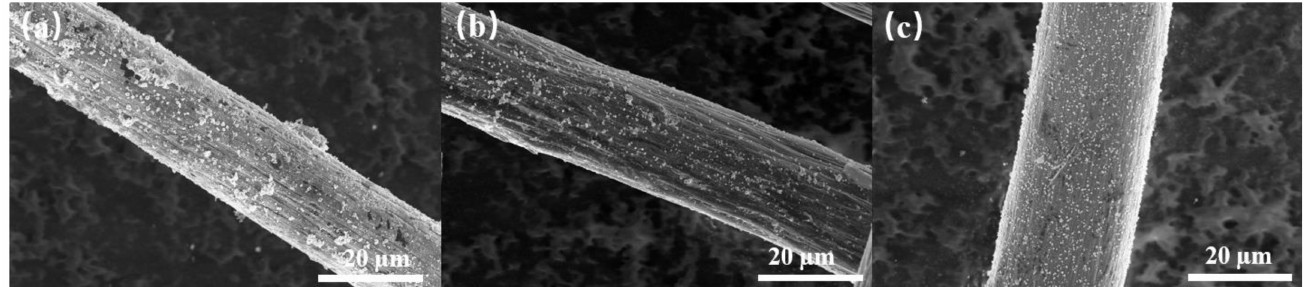
Figure 9. SEM of cathodes prepared under different currents: ( a ) Pd-loaded carbon felt electrode (1 mA), ( b ) Pd-loaded carbon felt electrode (10 mA), and ( c ) Pd-loaded graphite felt electrode (50 mA), (0.5 mg/cm 2 ).